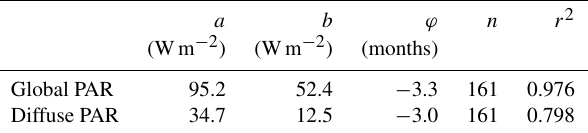
Table 3. Coefficients of the fit, number of data, and correlation co- efficient for the global and diffuse monthly PAR time